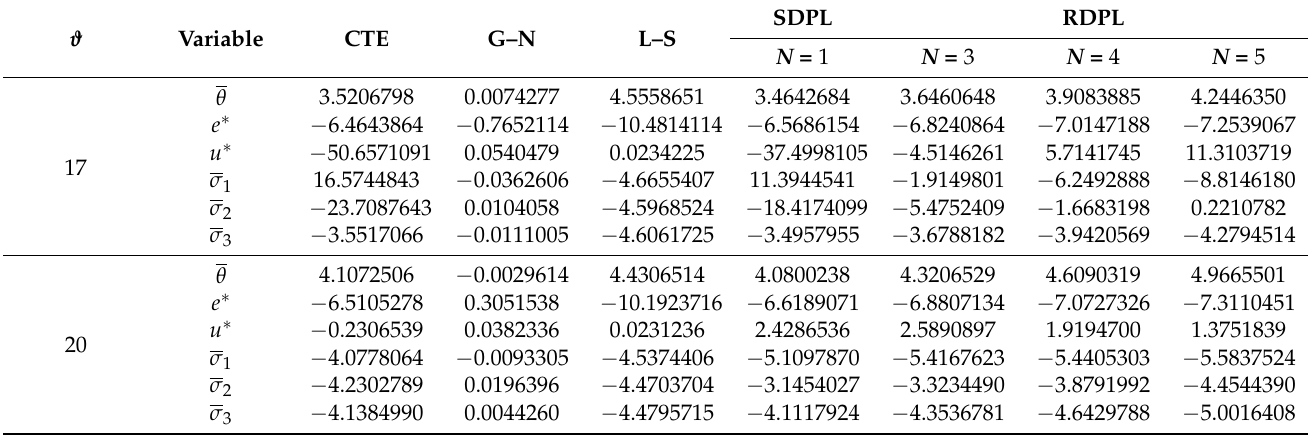
Table 1. Effect of the velocity of heat source ϑ on the field variables of different thermoelasticity theories with t = 0.03, r = 1.2, ω =